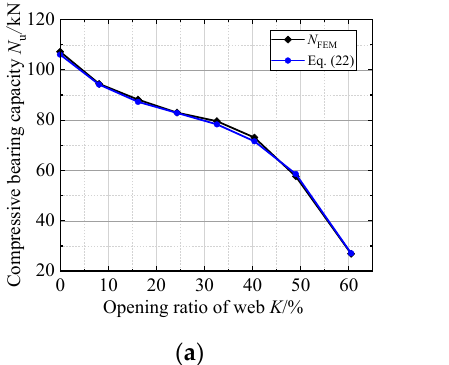
Figure 26. Validation of the proposed formulas for the combined column with opening ( a ) Comparisons of the bearing capacity of C-250-40-15-1.5-1900; ( b ) N u / N FEM.